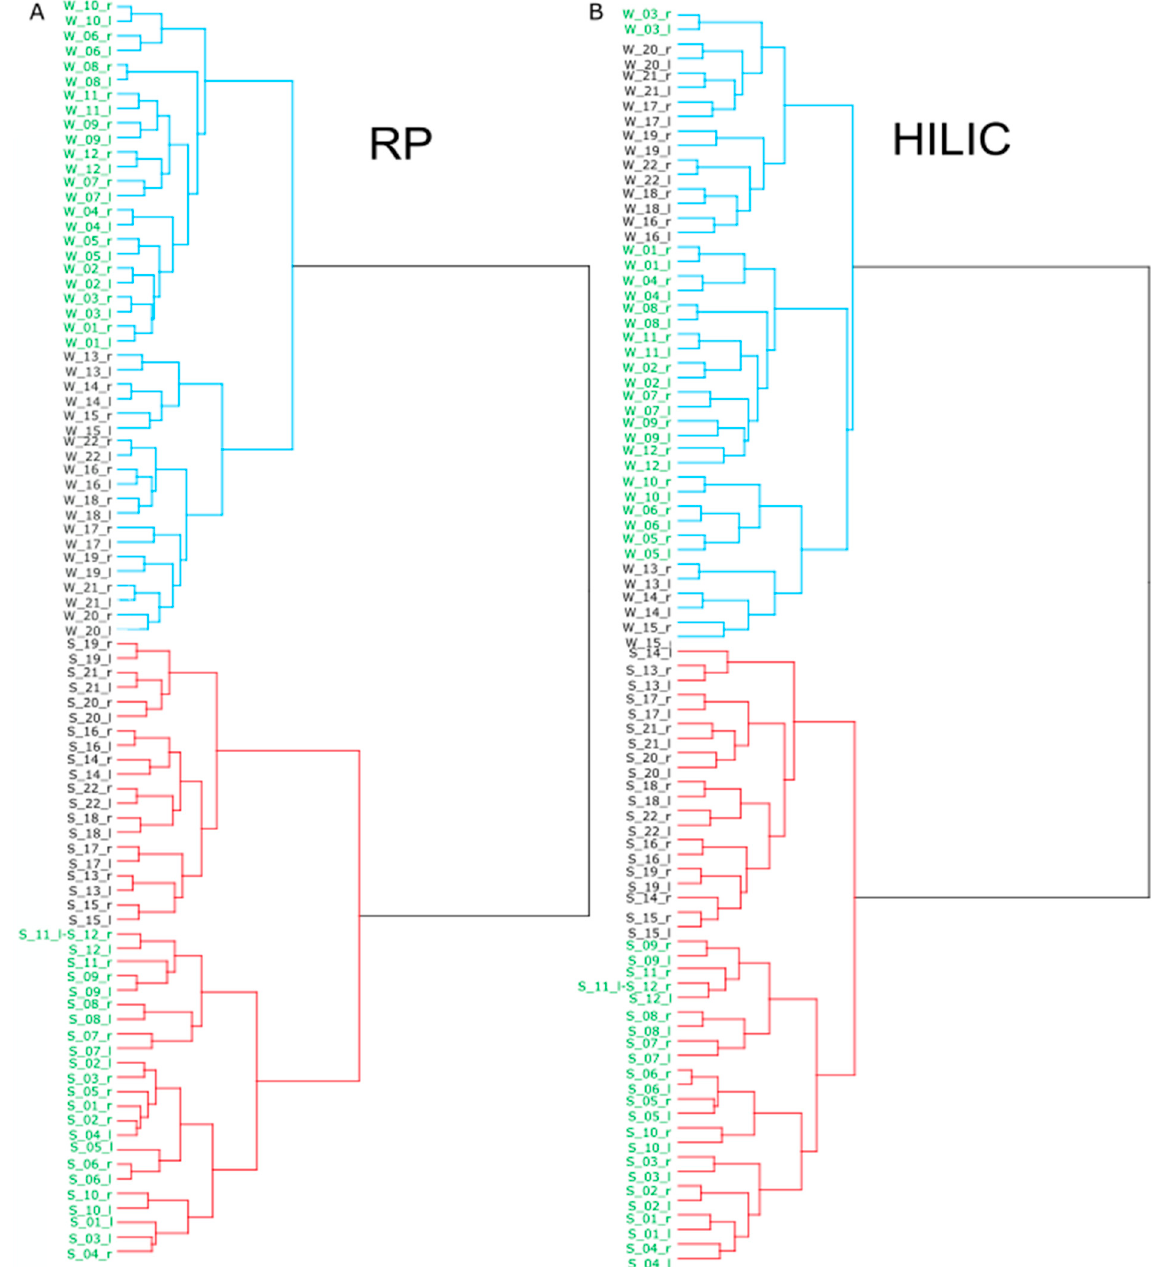
Figure 2. Dendrograms of hierarchical cluster analysis of swab and WET PREP for: RP ( A ) and HILIC ( B ). WET PREP samples noted in blue lines and swabs in red lines. Sample annotation is according to sampling method: WET PREP (W) and swab (S), individual (number following “W” or “S”), lateral side right (r) and left (l), and city of residence, location a (green) and location b (black).